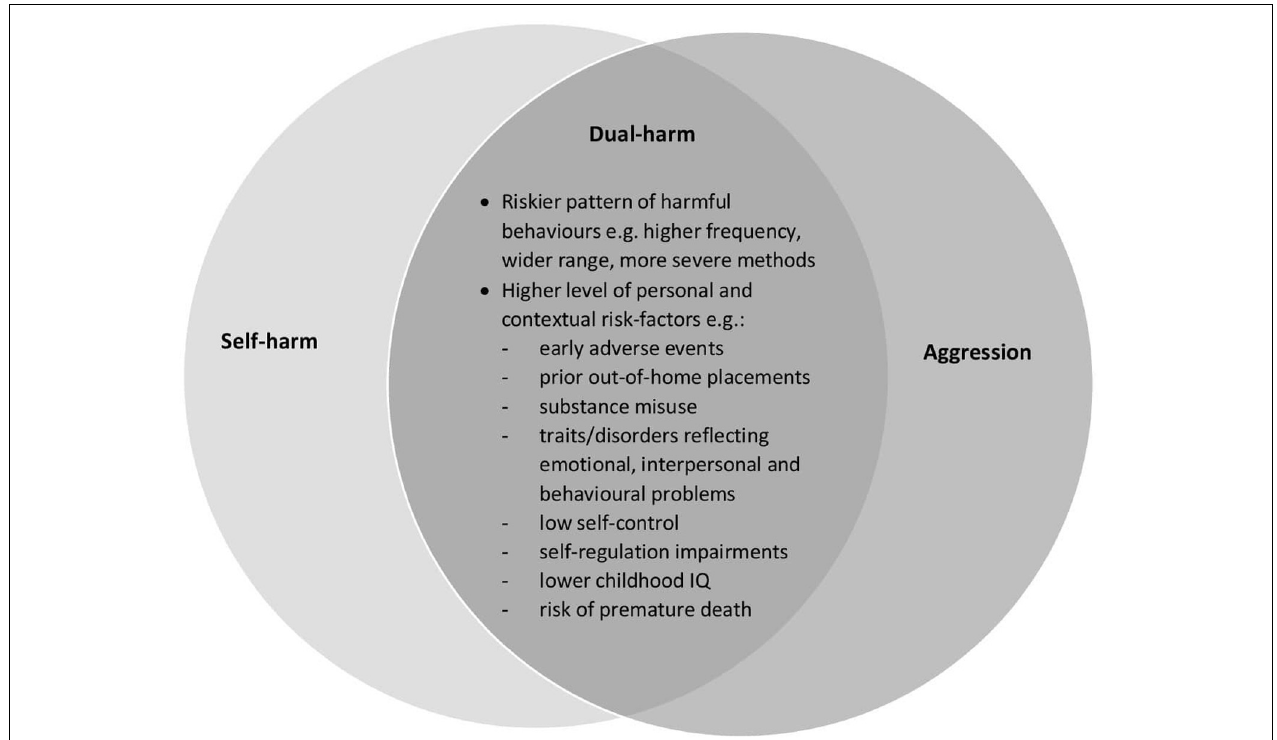
FIGURE 3 | Potential distinct profile of dual-harm. This Venn diagram highlights the potential mechanisms that may distinguish dual-harm as a separate clinical entity from the behaviours of self-harm alone and aggression alone. According to previous research, compared to those who engage in sole-harmful behaviours, individuals who have a history of dual-harm are significantly more likely to engage in a higher frequency of harmful behaviours, as well as a wider range and more severe methods of risky behaviours. Furthermore, these individuals have been found to have higher levels of personal and contextual risk-factors. Such higher levels of risk in those who dual-harm may be an important factor that distinguishes dual-harm from the sole-harm behaviours of self-harm and